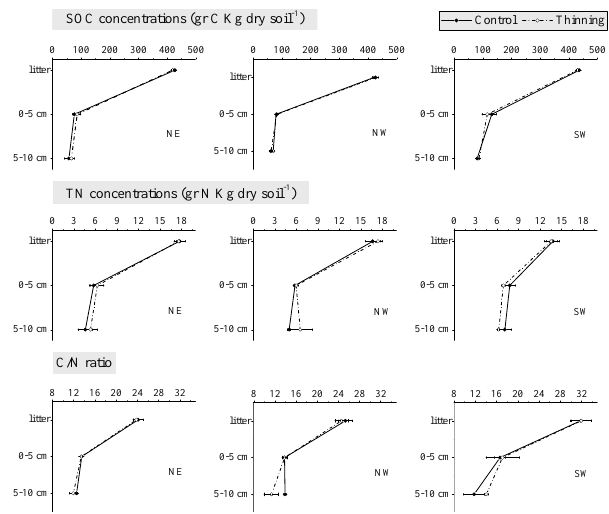
Figure 1. Effects of forest management (straight line: control; dotted line: thinned) on soil organic carbon concentrations (upper panels) and total nitrogen concentrations (middle panels) and C:N ratios (lower panels) at sites with different exposures (NE, NW, SW).